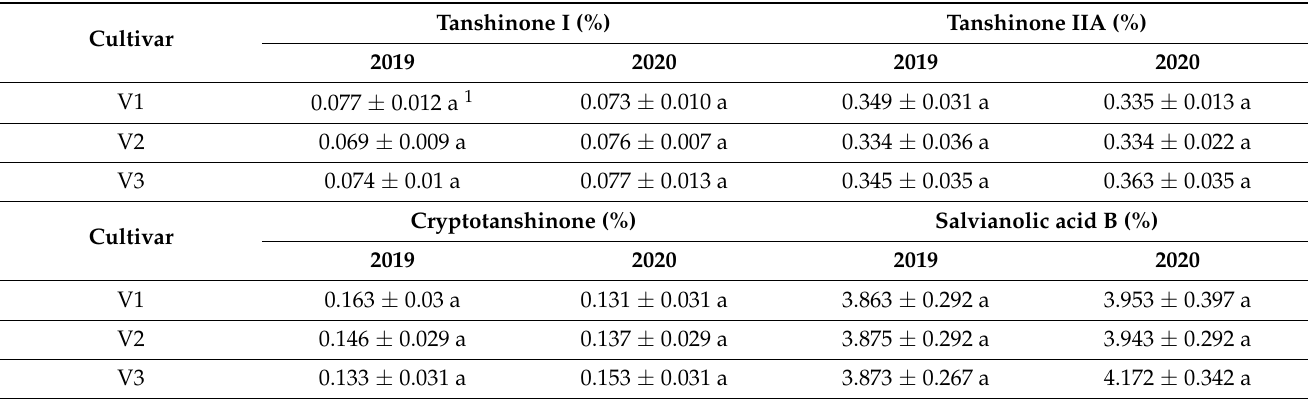
Table 5. Content of Tanshinone I, tanshinone IIA, cryptotanshinone, and salvianolic acid B in roots of three danshen cultivars grown in Mississippi, United States in 2019 and